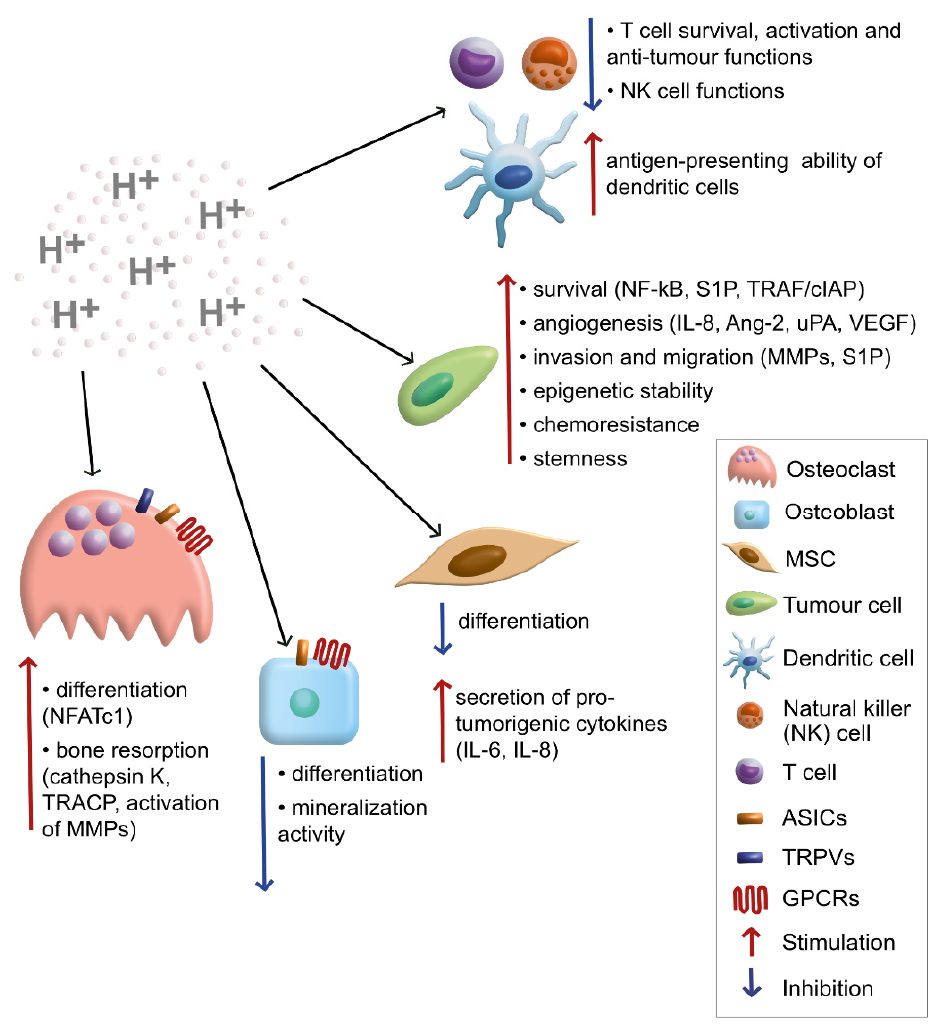
Figure 1. Graphical summary of the effects of extracellular acidosis on cells of the bone sarcoma microenvironment.